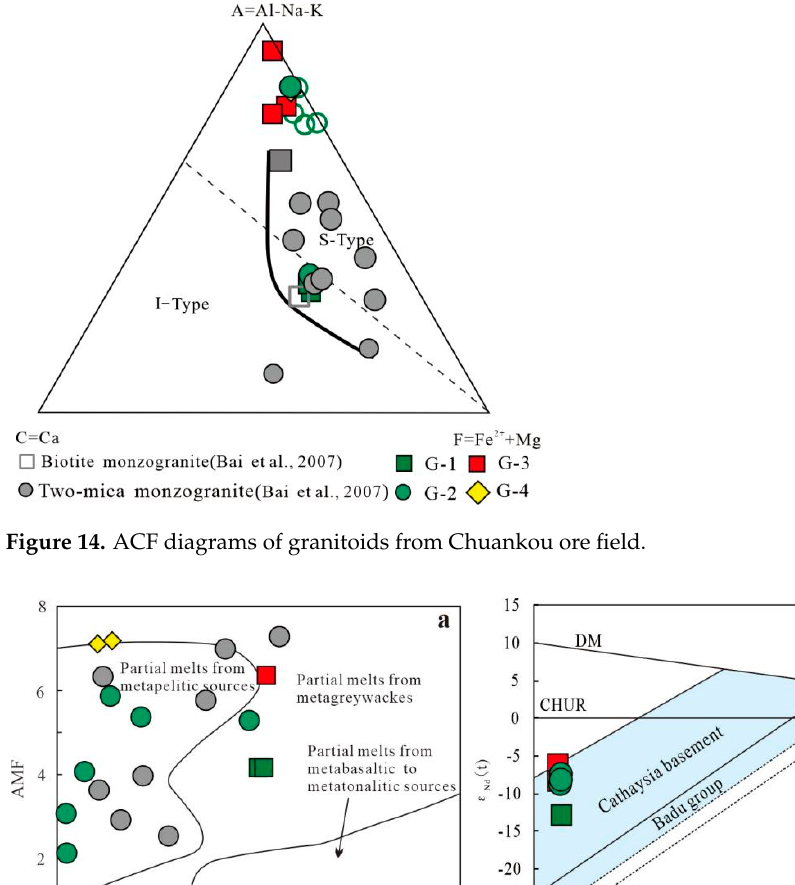
Figure 13. Genetic type discrimination diagram of intrusions in Chuankou ore field, ( a ) ALK versus